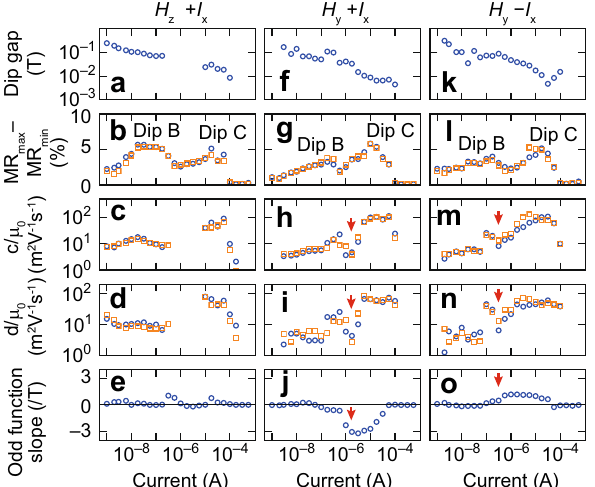
Figure 5. Dip gap, MR ratio, c value, d value and odd function slope obtained from our magnetoresistance measurements. ( a – e ) Data obtained in H z + I x measurement. ( f – j ) Data obtained in H y + I x measurement. ( k – o ) Data obtained in H y − I x measurement. Blue circles and orange squares in ( b – d , g – i,l – o ) correspond to + scan and − scan,